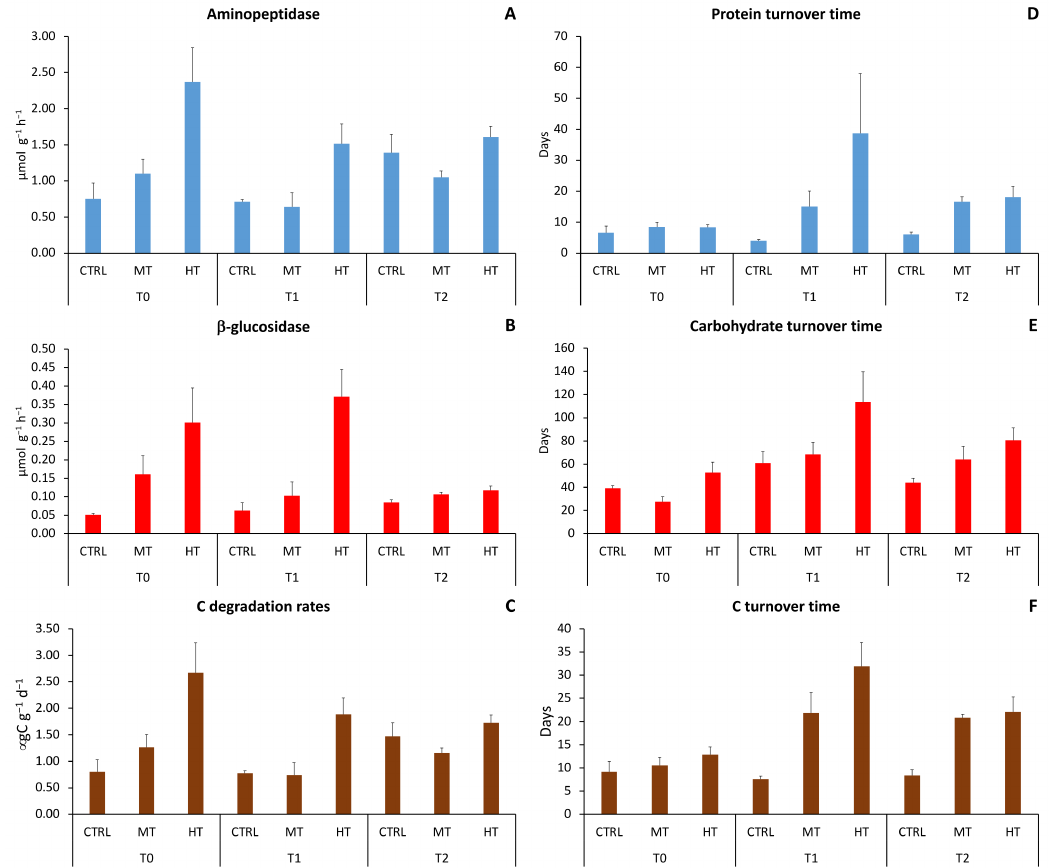
Figure 4. Changes in extracellular enzymatic ( A ) aminopeptidase, ( B ) β -glucosidase activities, ( C ) C degradation rates, ( D ) protein turnover time, ( E ) carbohydrate turnover time, and ( F ) C turnover time in the three sampling sites at each sampling time. CTRL = control; MT = medium temperature anomaly; HT = high temperature anomaly. T 0 = before PPW injection; T 1 = after 3 weeks from PPW injection; T 2 = after 11 weeks from PPW injection.